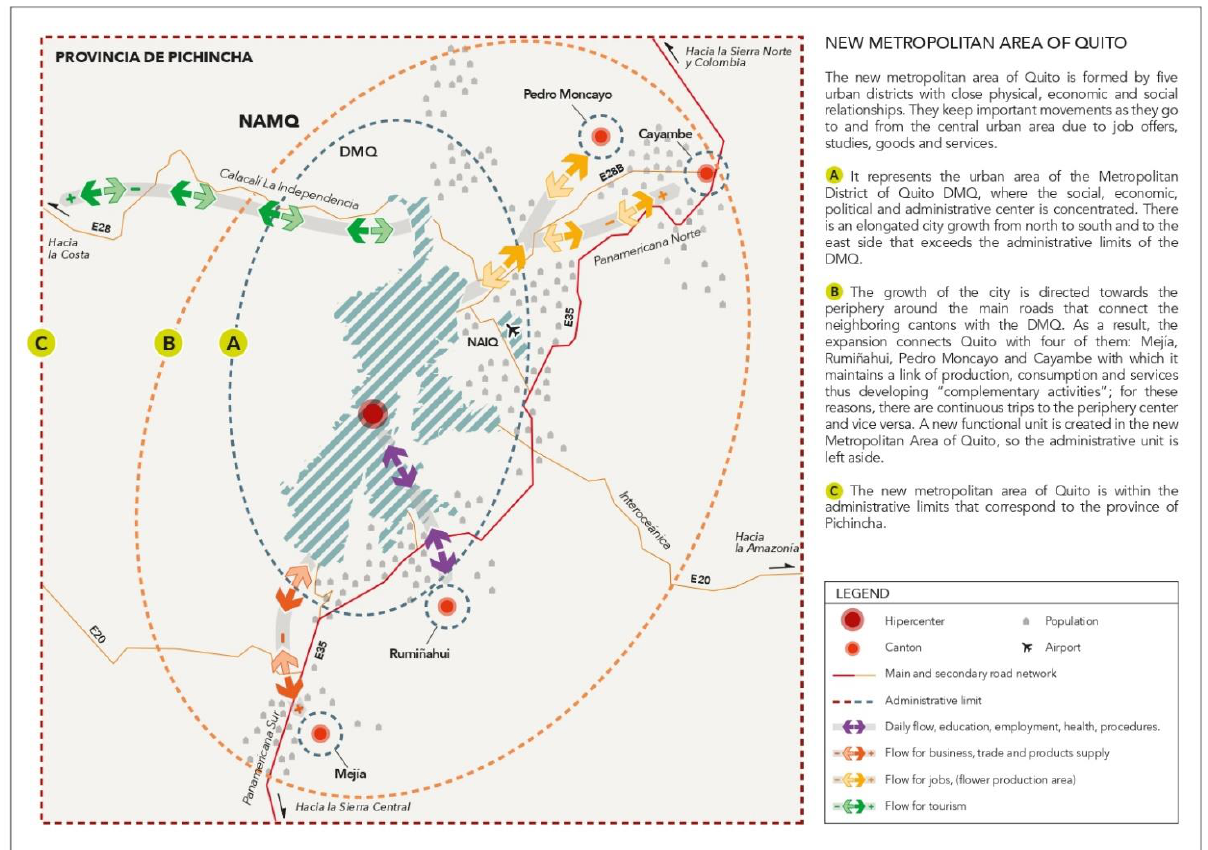
Figure 8. Model of the new metropolitan area of Quito. Own